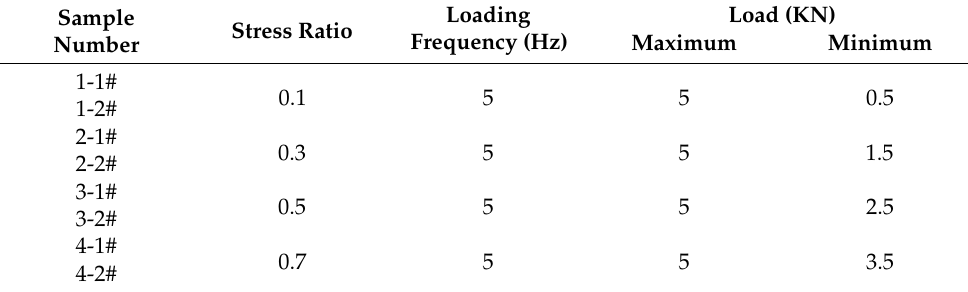
Table 1. Test scheme.